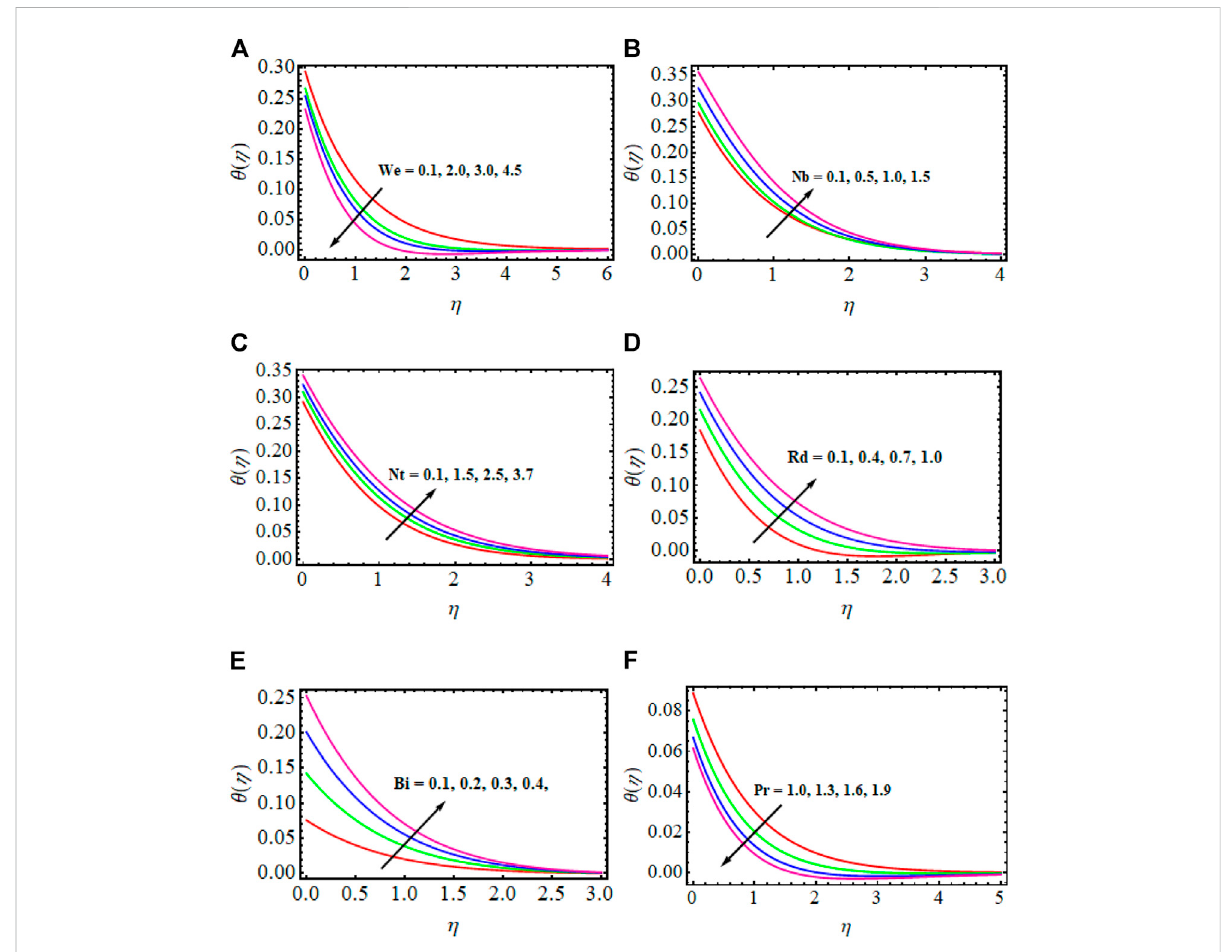
FIGURE 4 Alteration of We , Nb , Nt , Rd , Bi , and Pr with temperature pro fi le ( η )